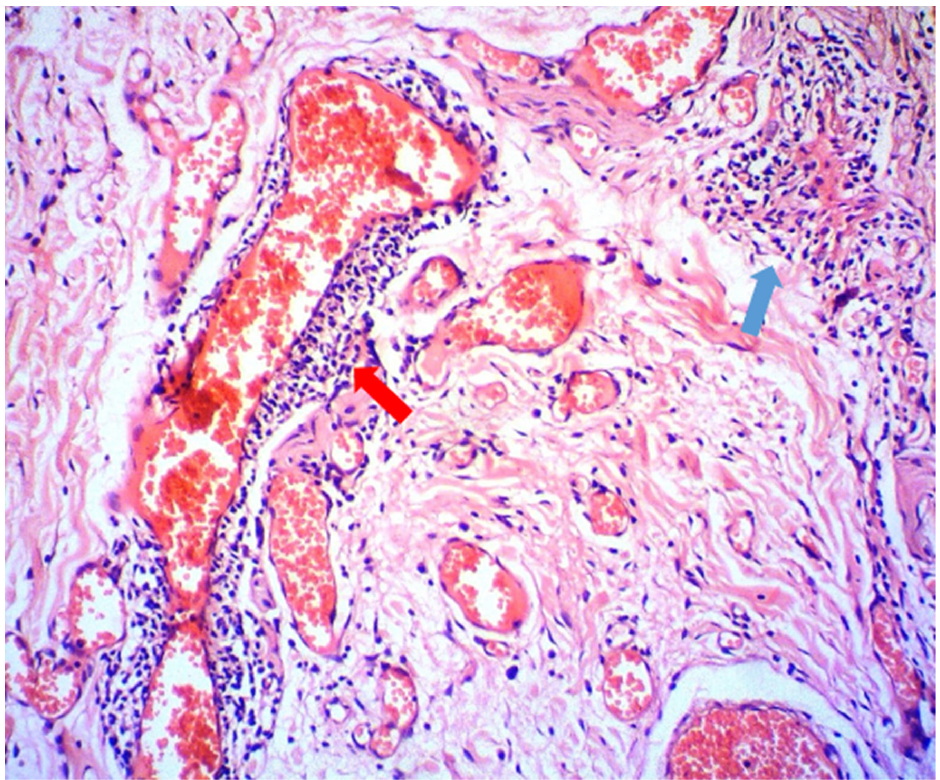
Figure 2. Perivascular inflammatory infiltration of lymphocytes (indicated with a red arrow) and small tuberculoid granuloma (indicated with a blue arrow) (HE, 100×).